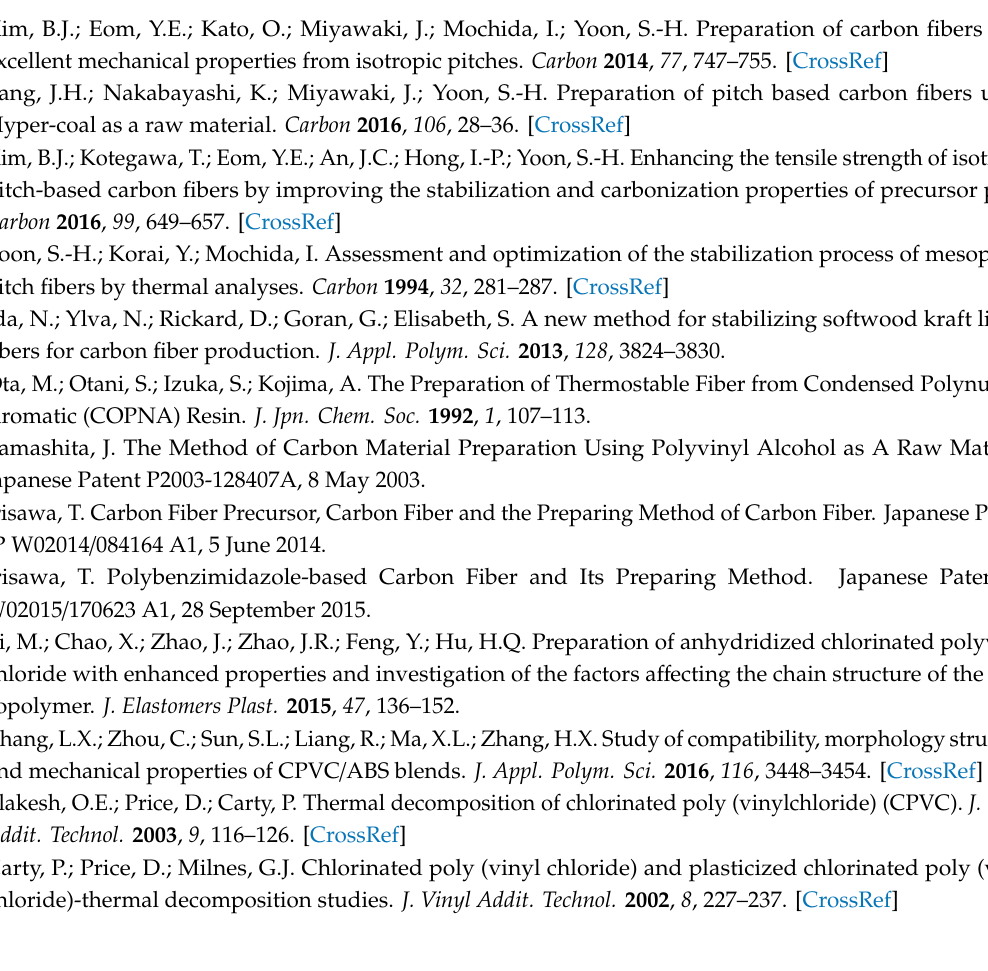
Figure S1. Thermo-gravimetric analysis (TGA) profiles of chlorinated polyvinyl chloride (CPVC) and polyvinyl chloride (PVC) under N 2 flow, showing weight loss (left y-axis) and di ff erential curves of the weight loss (right y-axis) from ambient temperature to 1000 ◦ C; Figure S2. Scanning electron microscopy (SEM) micrographs of (a) lateral and (b) cross-sectional views of the CPVC derived carbon